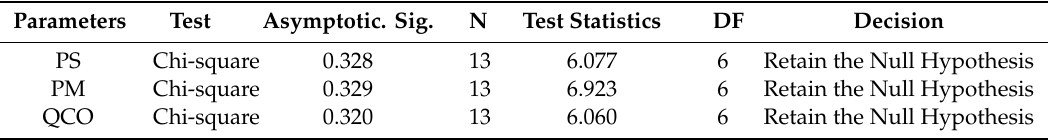
Table 16. Chi-square statistical analysis results from performance expectation of project professionals of lean thinking and Industry 4.0.